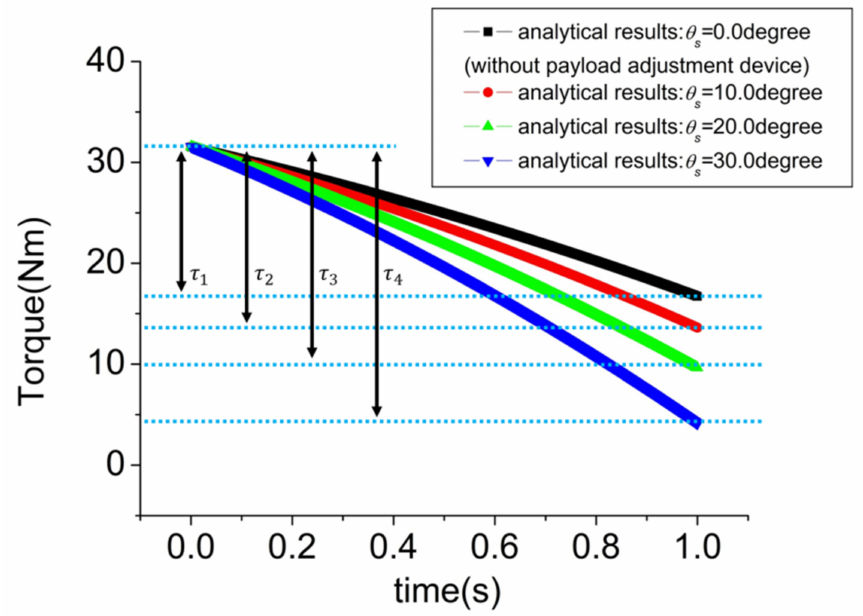
Figure 7. Hip joint torques when the exoskeleton with a payload adjustment device performs hip